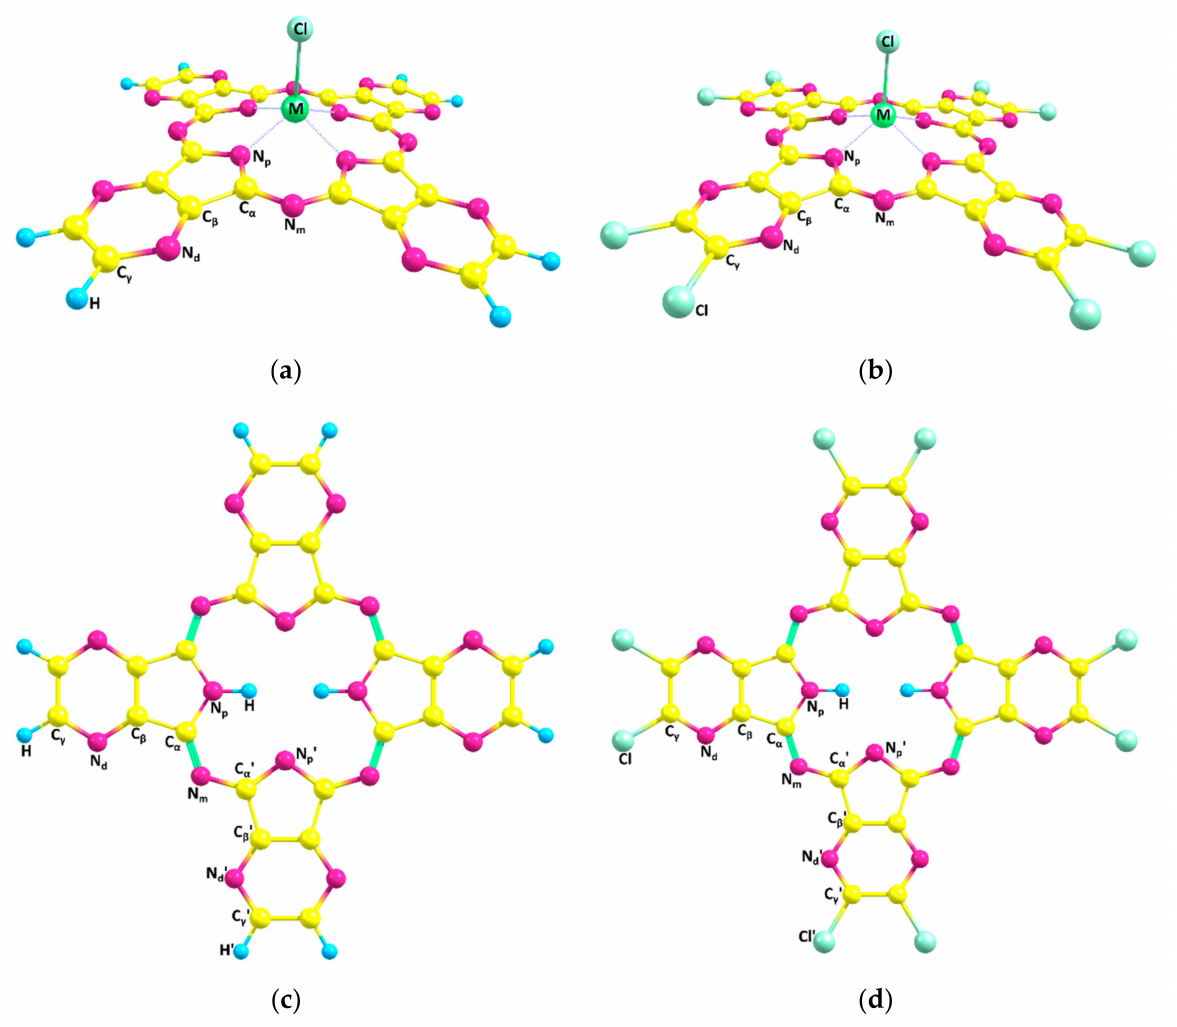
Figure 1. Molecular structures of the Al(III), Ga(III) and In(III) complexes with pyrazinopor- phyrazine (M(Cl)TPyzPA) ( a ), octachloropyrazinoporphyrazines (M(Cl)TPyzPACl 8 ) ( b ) and metal- free molecules (( c ) and ( d ), respectively) with atom